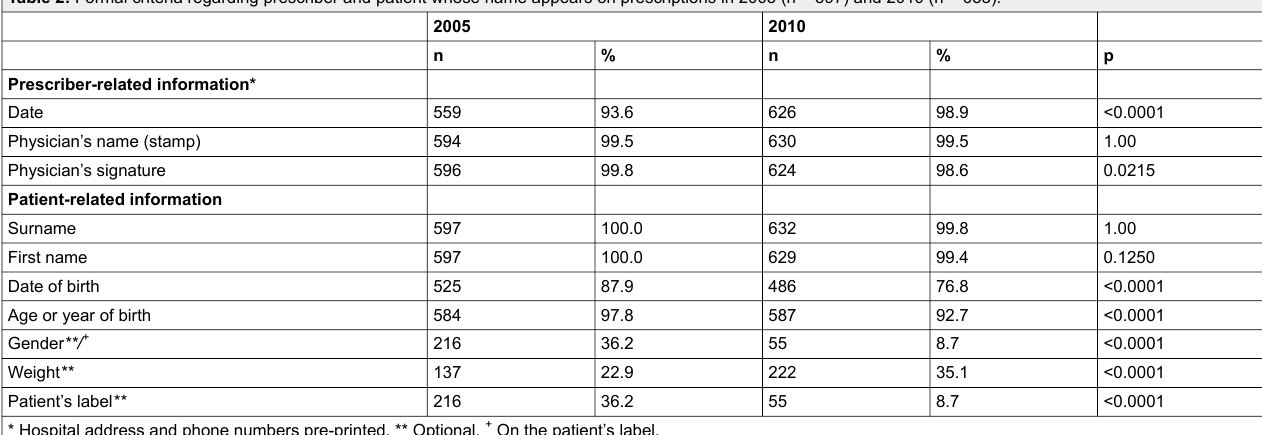
Table 2: Formal criteria regarding prescriber and patient whose name appears on prescriptions in 2005 (n = 597) and 2010 (n = 633).